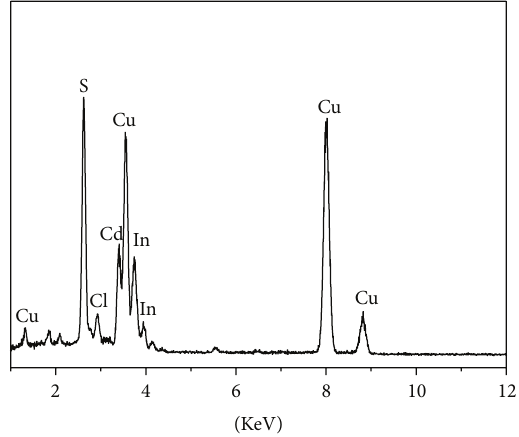
Figure 4: Energy-dispersive X-ray analysis spectra of CdIn 2 S 4 prepared at 500 ∘ C.